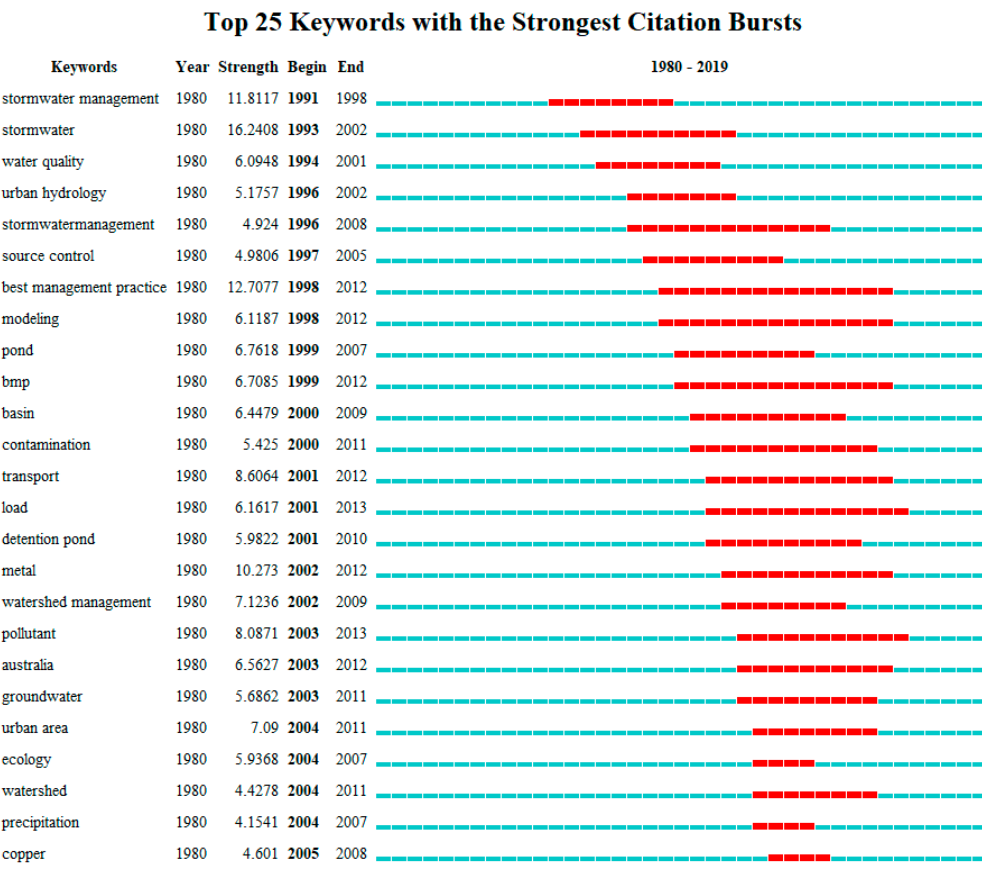
Figure 7. Time sequence of keywords.